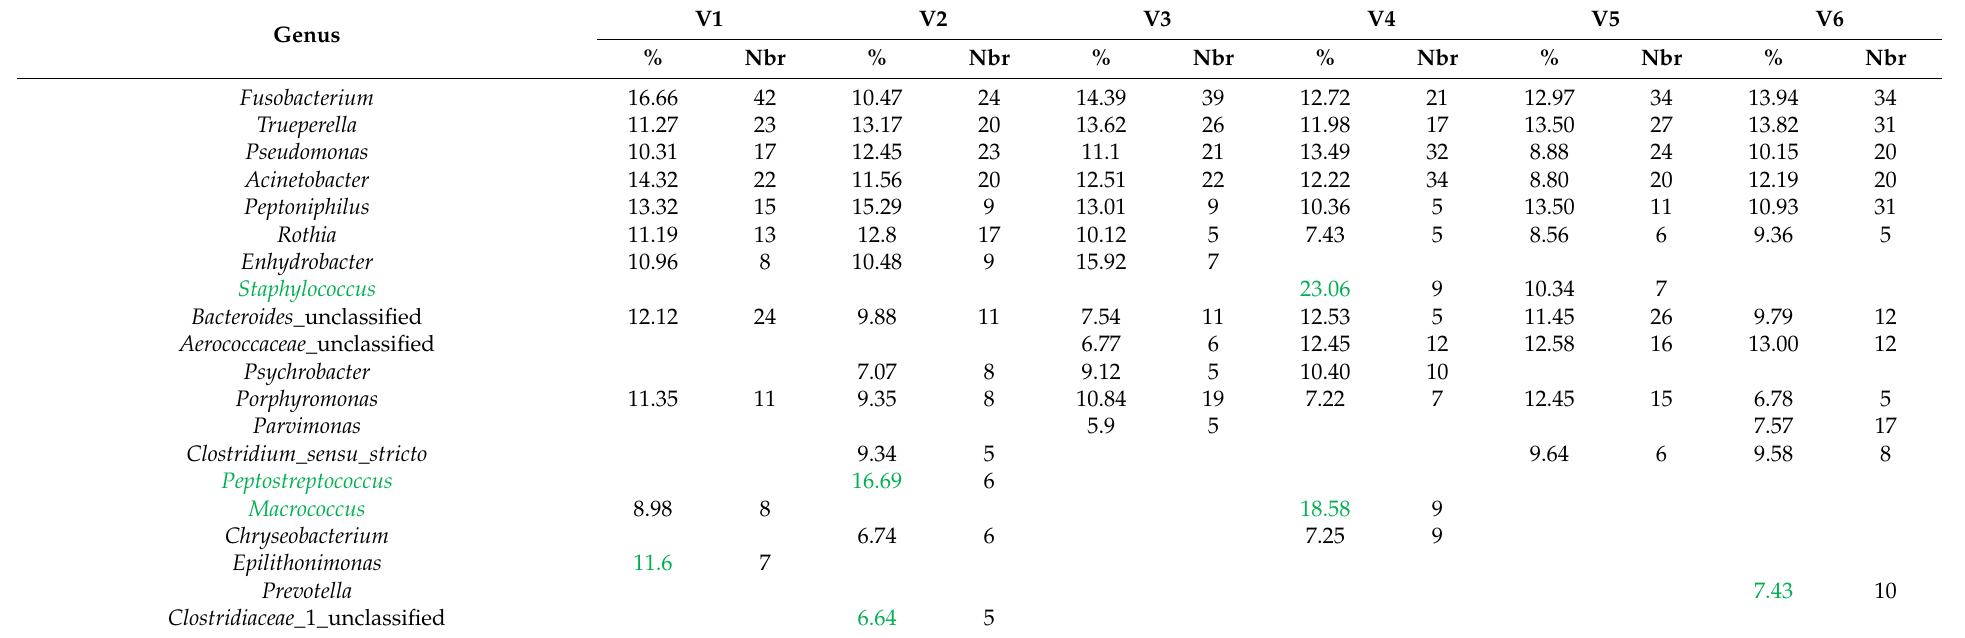
Table 1. Bacterial genera with an average relative abundance equal to or greater than 5% according to the six visits independent of production line.